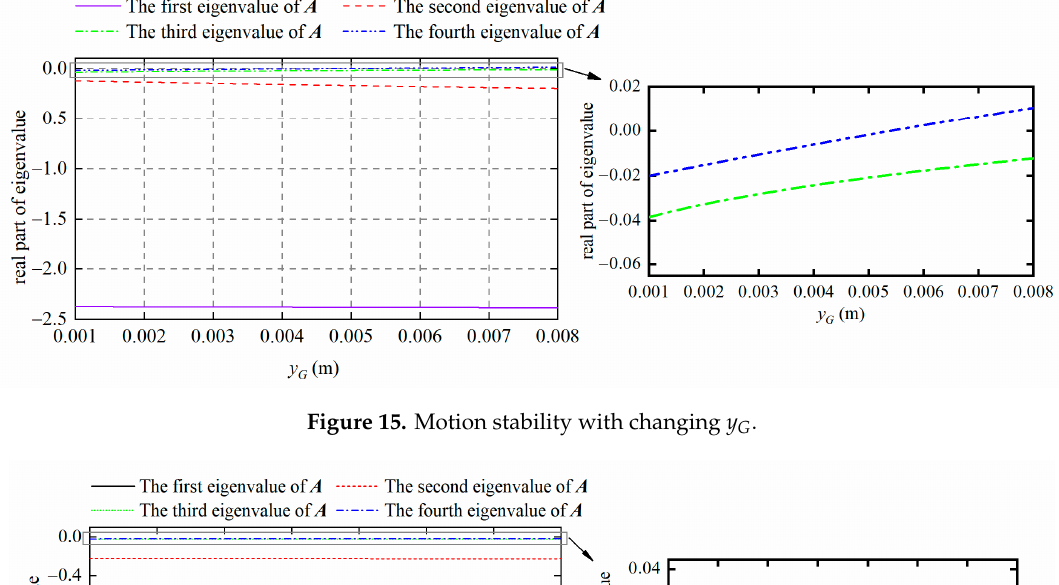
Figure 15. Motion stability with changing y G .